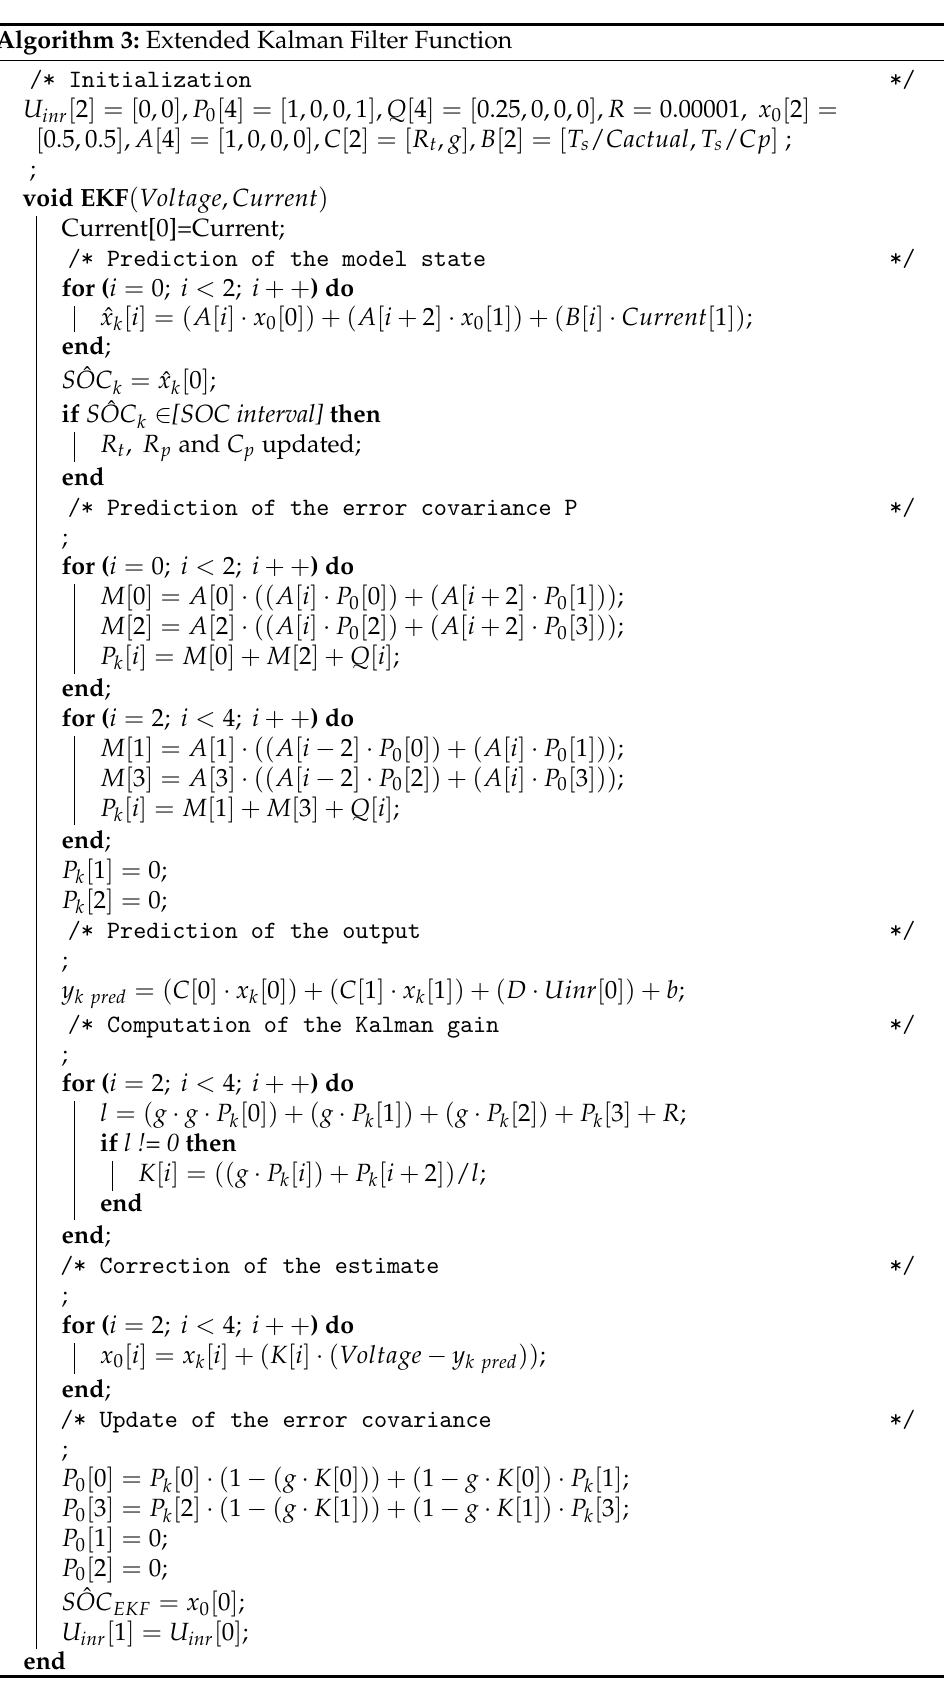
Algorithm 3: Extended Kalman Filter